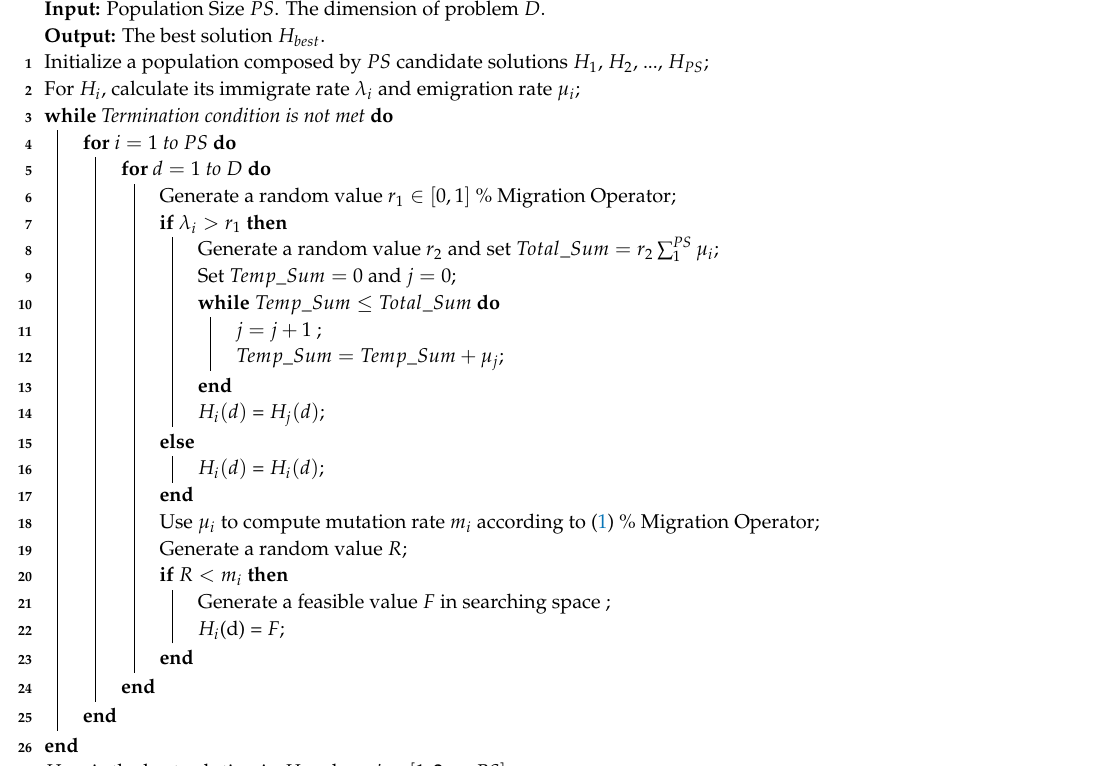
Algorithm 1: Pseudo-codes of Biogeography-based